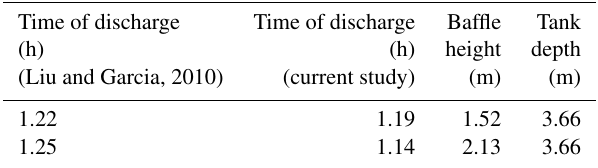
Table 2. Tracer curve outcome for the two aforementioned